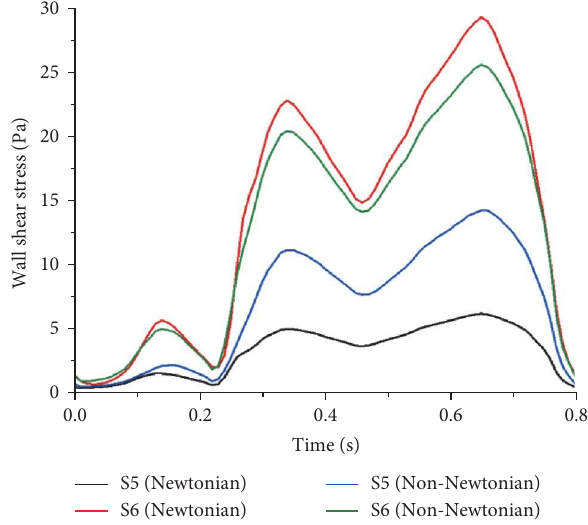
F IGURE 9: Maximum velocities at both ends of the stenosis.